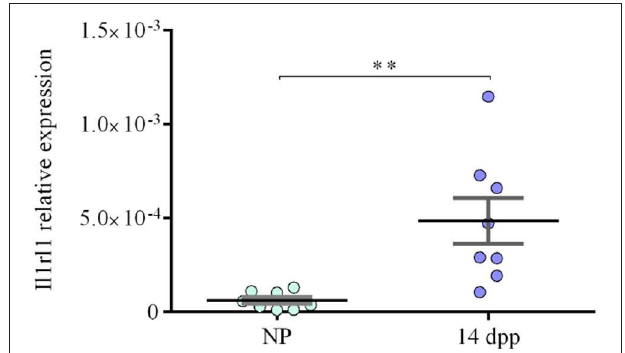
FIGURE 1 | Expression levels of Il1rl1 in pure isolated B cells from pregnant and non-pregnant mice. qPCR analysis showing significantly higher relative expression levels of Il1rl1 normalized to β -actin, in splenic B cells isolated from pregnant mice on day 14 of pregnancy (P, n = 8) as compared to B cells isolated from non-pregnant (NP, n = 8) control females (6 × 10 − 5 ± 1 × 10 − 5 vs. 4 × 10 − 4 ± 1 × 10 − 4 ). Data is shown as mean ± SEM. ** p < 0.01 as analyzed by unpaired t-